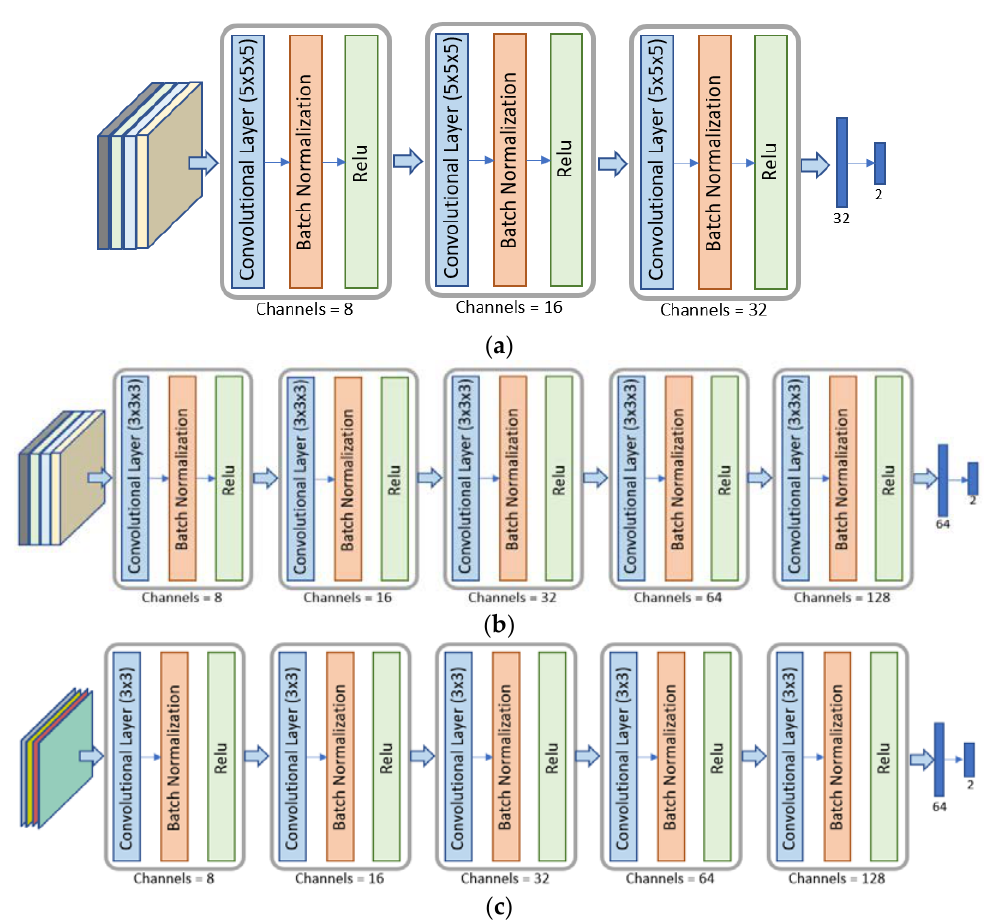
Figure 3. Architectures of the different CNNs used. Panel ( a ): The SFB-NET is a 3D CNN with three reduction blocks and two fully connected layers. Panel ( b ): The VB-NET is a 3D CNN with five reduction blocks and two fully connected layers. Panel ( c ): The 2DS-NET is a 2D CNN with five reduction blocks and two fully connected layers.